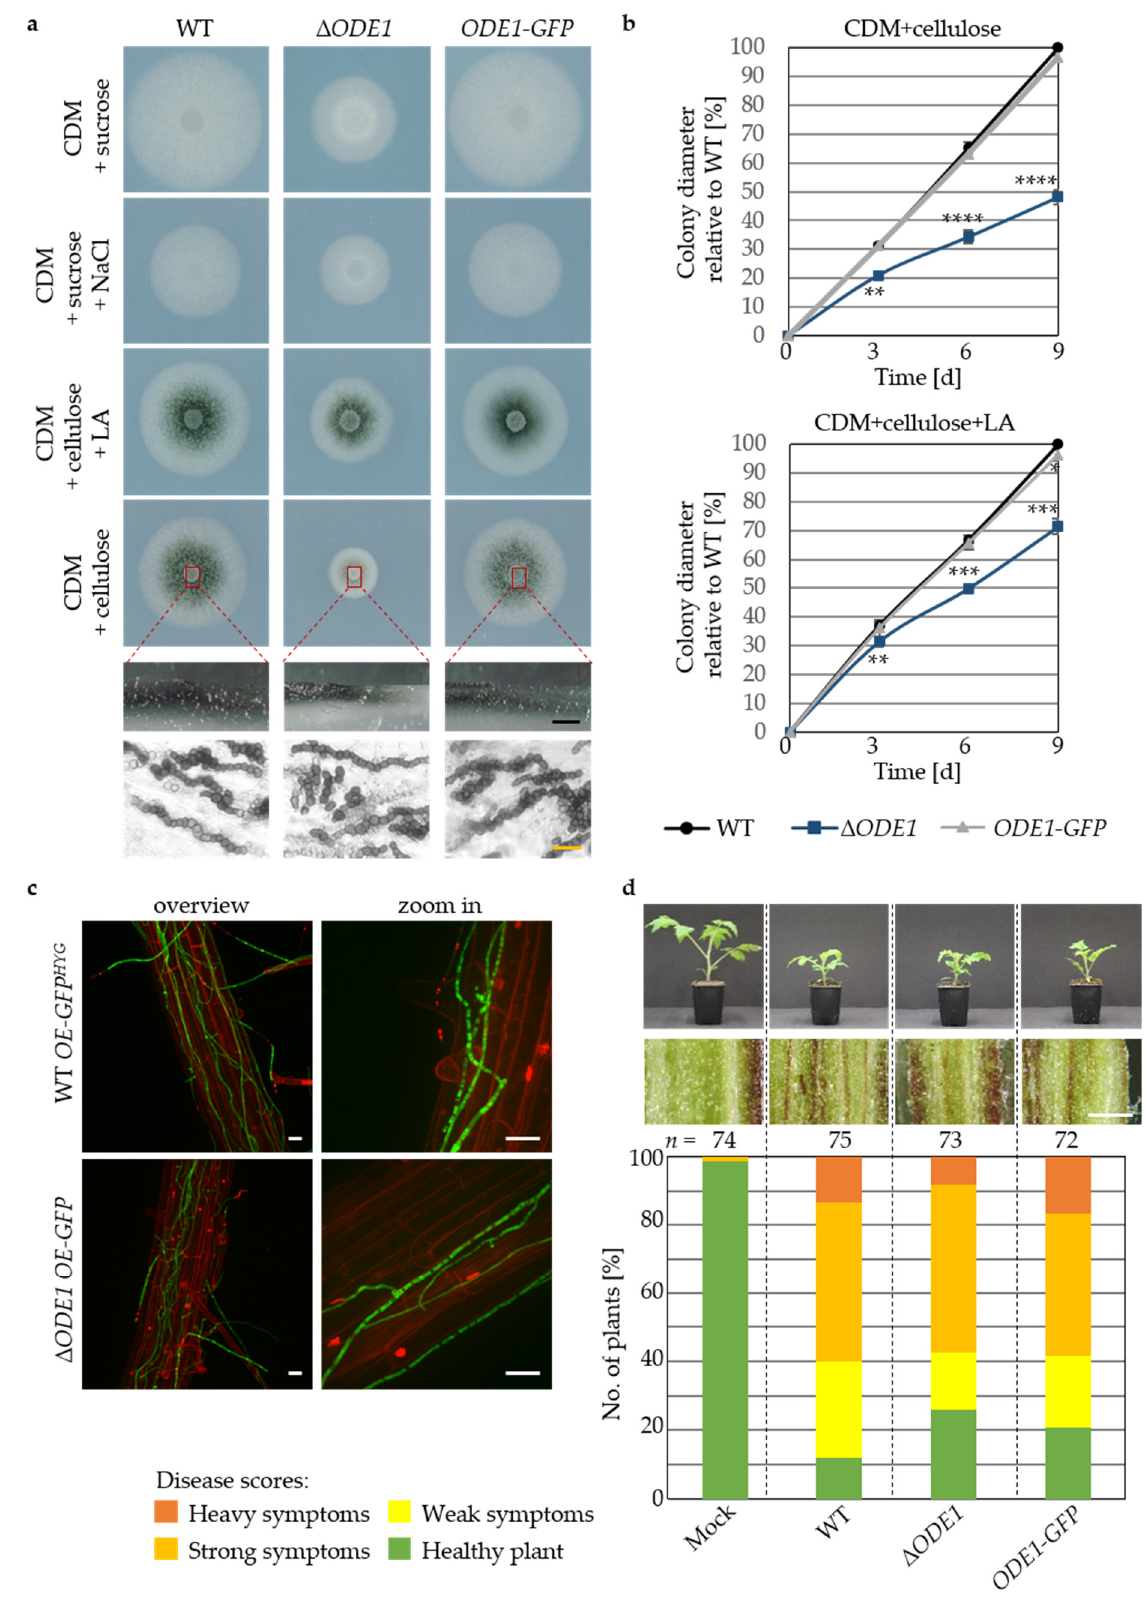
Figure 5. Verticillium dahliae ODE1 contributes primarily to vegetative growth with only minor effects on plant disease symptoms. The V. dahliae ODE1 deletion strain ( ∆ ODE1 ), wildtype (WT), and the complementation strain harboring ODE1-GFP at the endogenous locus under control of the native promoter as well as wildtype and ODE1 deletion strain constitutively expressing ectopic GFP (WT OE-GFP HYG , ∆ ODE1 OE-GFP ) were compared. ( a ) Vegetative growth and microsclerotia formation ex planta 9 d after spot inoculation on CDM supplemented with NaCl (0.5 M), CDM with